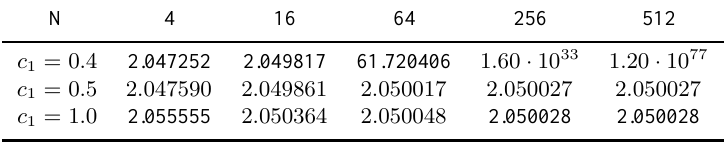
Table 4. Case d = 2 , m = 2